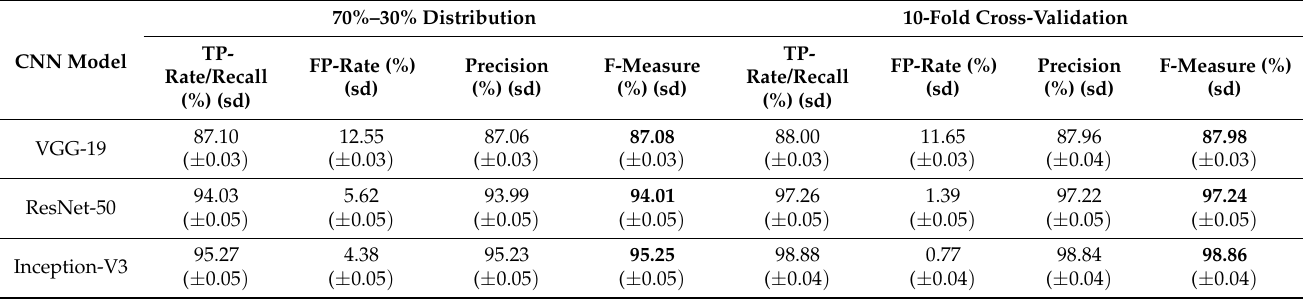
Table 5. Performance of CNN models with respect to diverse metrics using dataset 1.